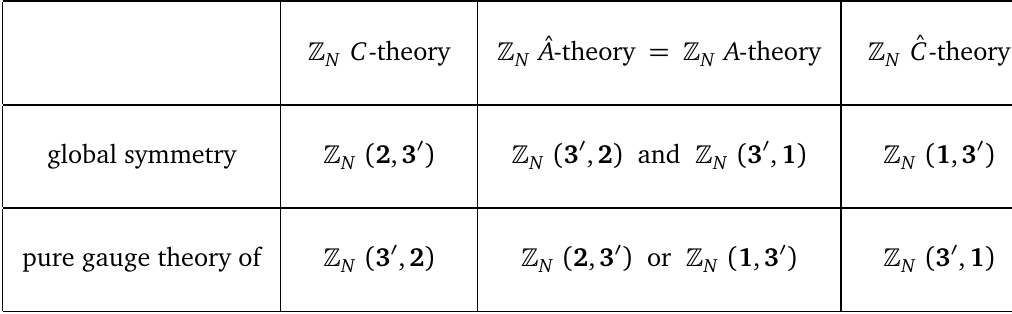
(cid:90) C -theory N